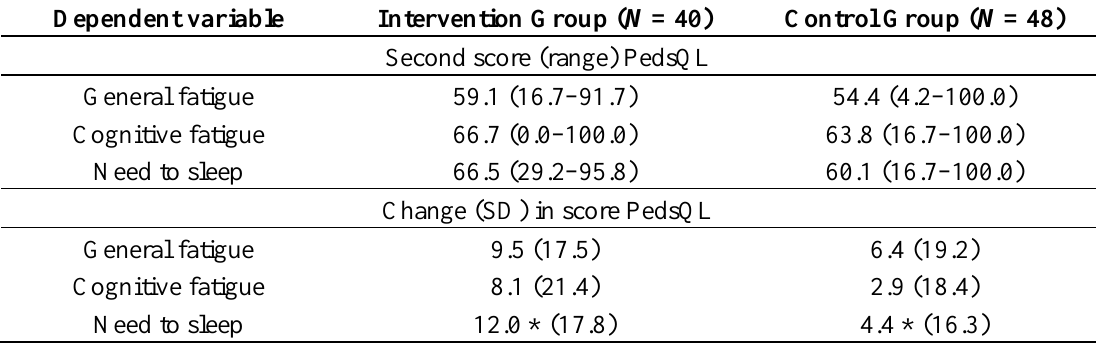
Table 3. Mean scores (range) after following the diet for three months and change (SD) in symptoms of fatigue measured by pediatric quality of life (PedsQL)